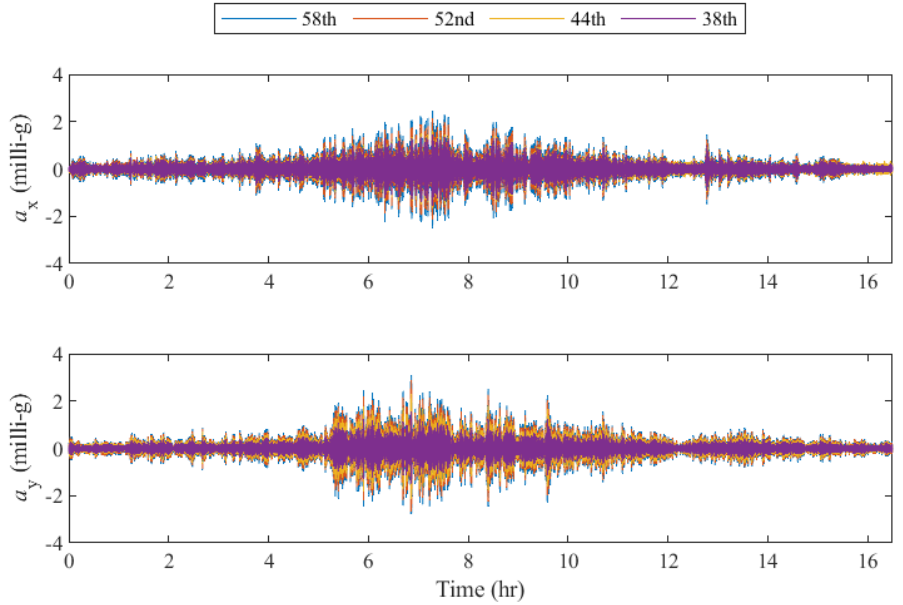
Figure 9. Time history of Leatop Plaza under Typhoon Vicente (origin: 22:30 July 23).